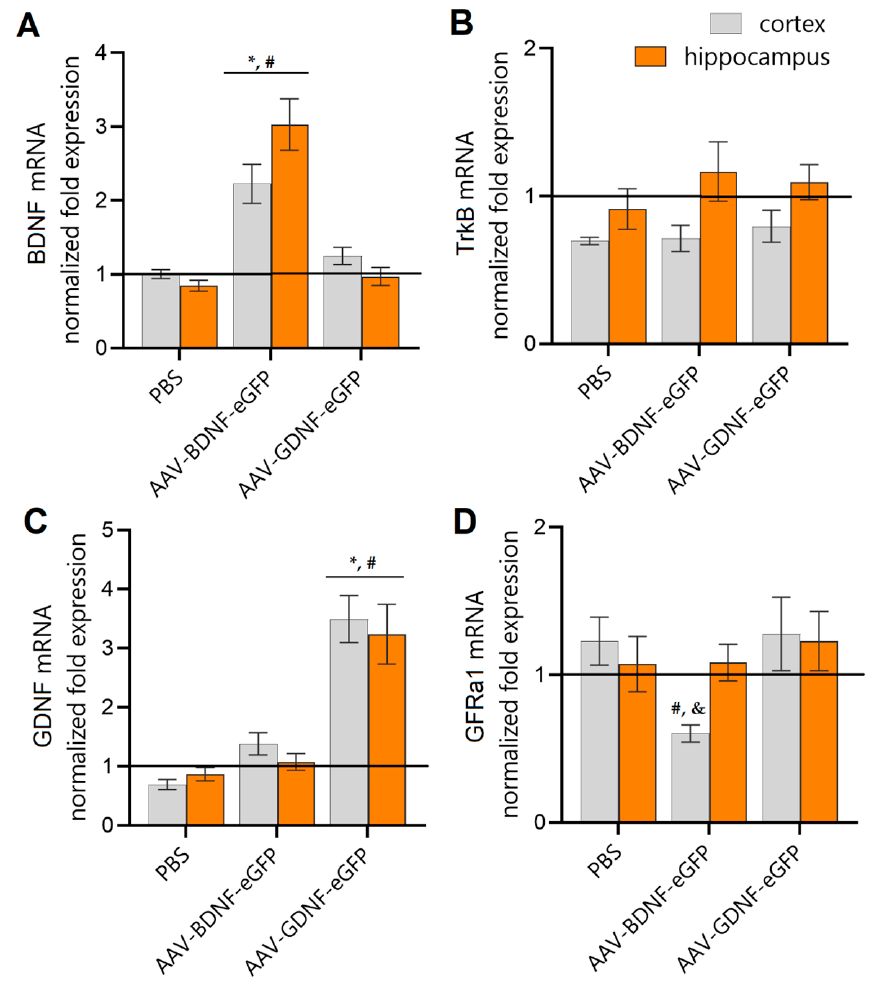
Figure 3. Assessment of the level of mRNA expression of neurotrophic factors BDNF ( A ) and GDNF ( C ), and their key receptors TrkB ( B ) and GFRa1 ( D ), in the cerebral cortex and hippocampus of mice 7 days after the provocation of audiogenic seizures. Data were normalized relative to values of the “Sham” group. *-vs. “Sham”, #-vs. “PBS”, &-vs. levels in the hippocampus within the group, p < 0.05, Kruskal-Wallis test with Dunn’s multiple comparisons test.